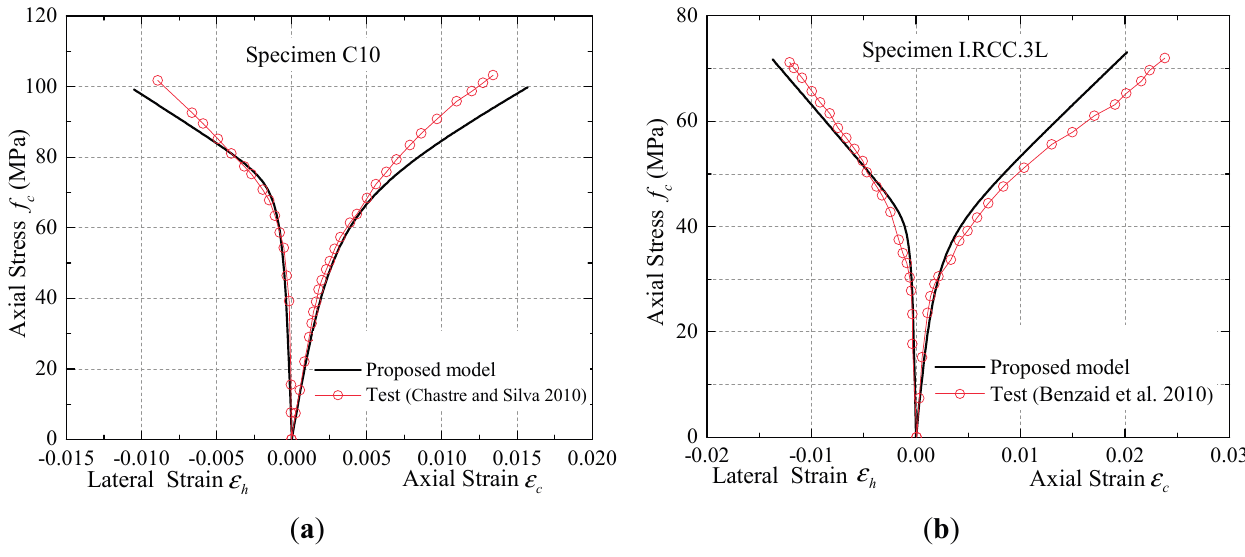
Figure 21. Performance of proposed model for FRP–TSR confined concrete: ( a ) Specimen C10 from Chastre and Silva (2010) [58]; ( b ) Specimen I.RCC.3L from Benzaid et al. , (2010)